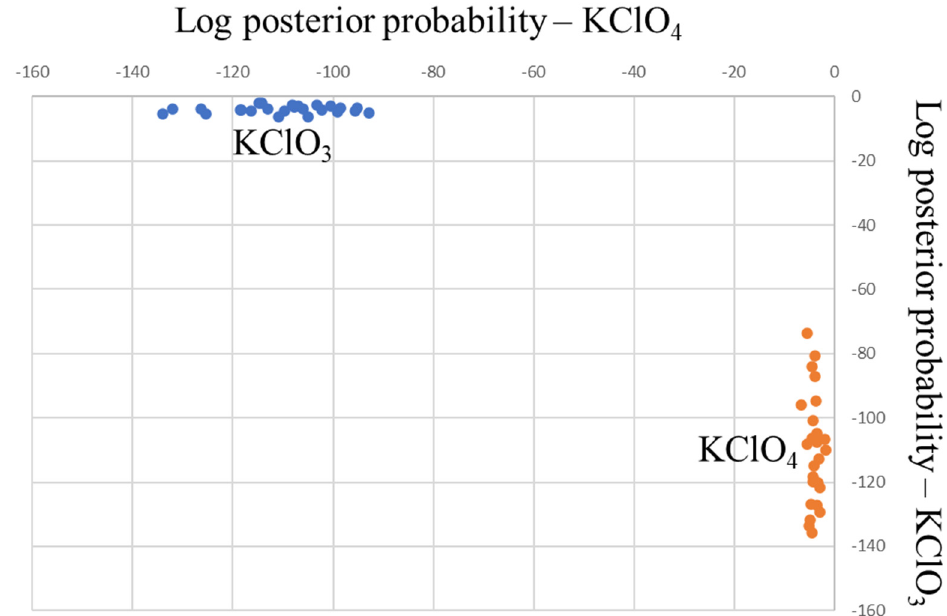
Figure 10. LDA discrimination plot (KClO 4 assignment vs. KClO 3 assignment) for the potassium chlorate and perchlorate NIR calibration data (5 samples, 5 spectra per sample, 25 spectra in total each). The full separation of the KClO 4 and KClO 3 clusters (orange and blue dots, respectively) indicate 100% model accuracy.